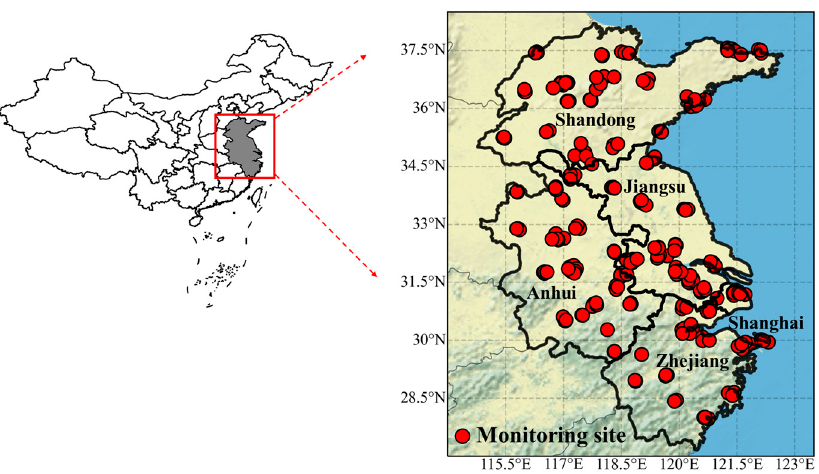
Figure 1. Schematic diagram of study area.